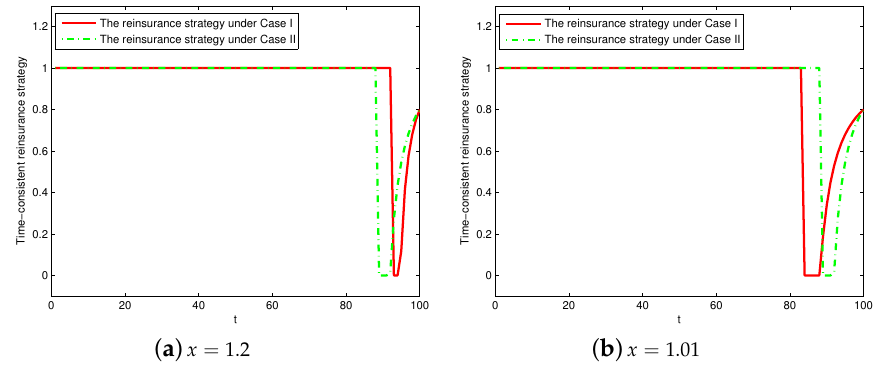
Figure 7. Nash equilibrium reinsurance strategy under the variance value premium principle ( α =